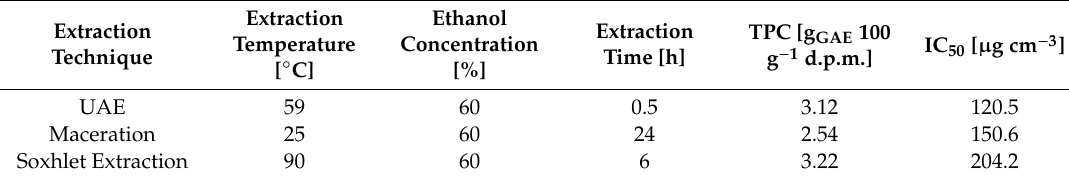
Table 6. The comparison of UAE with maceration and Soxhlet